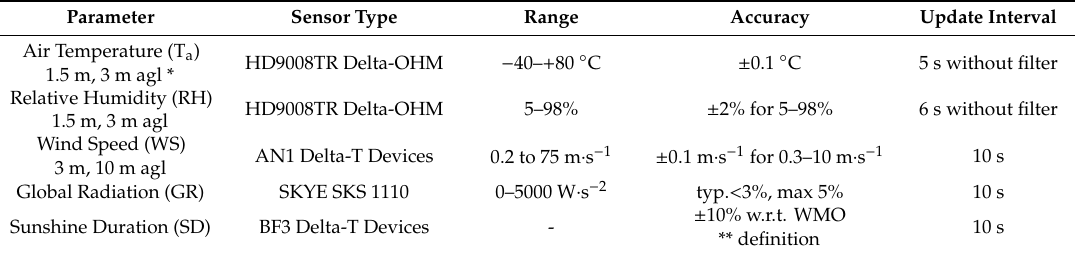
Table 1. Technical characteristics from meteorological station’s sensors within Agricultural University of Athens.